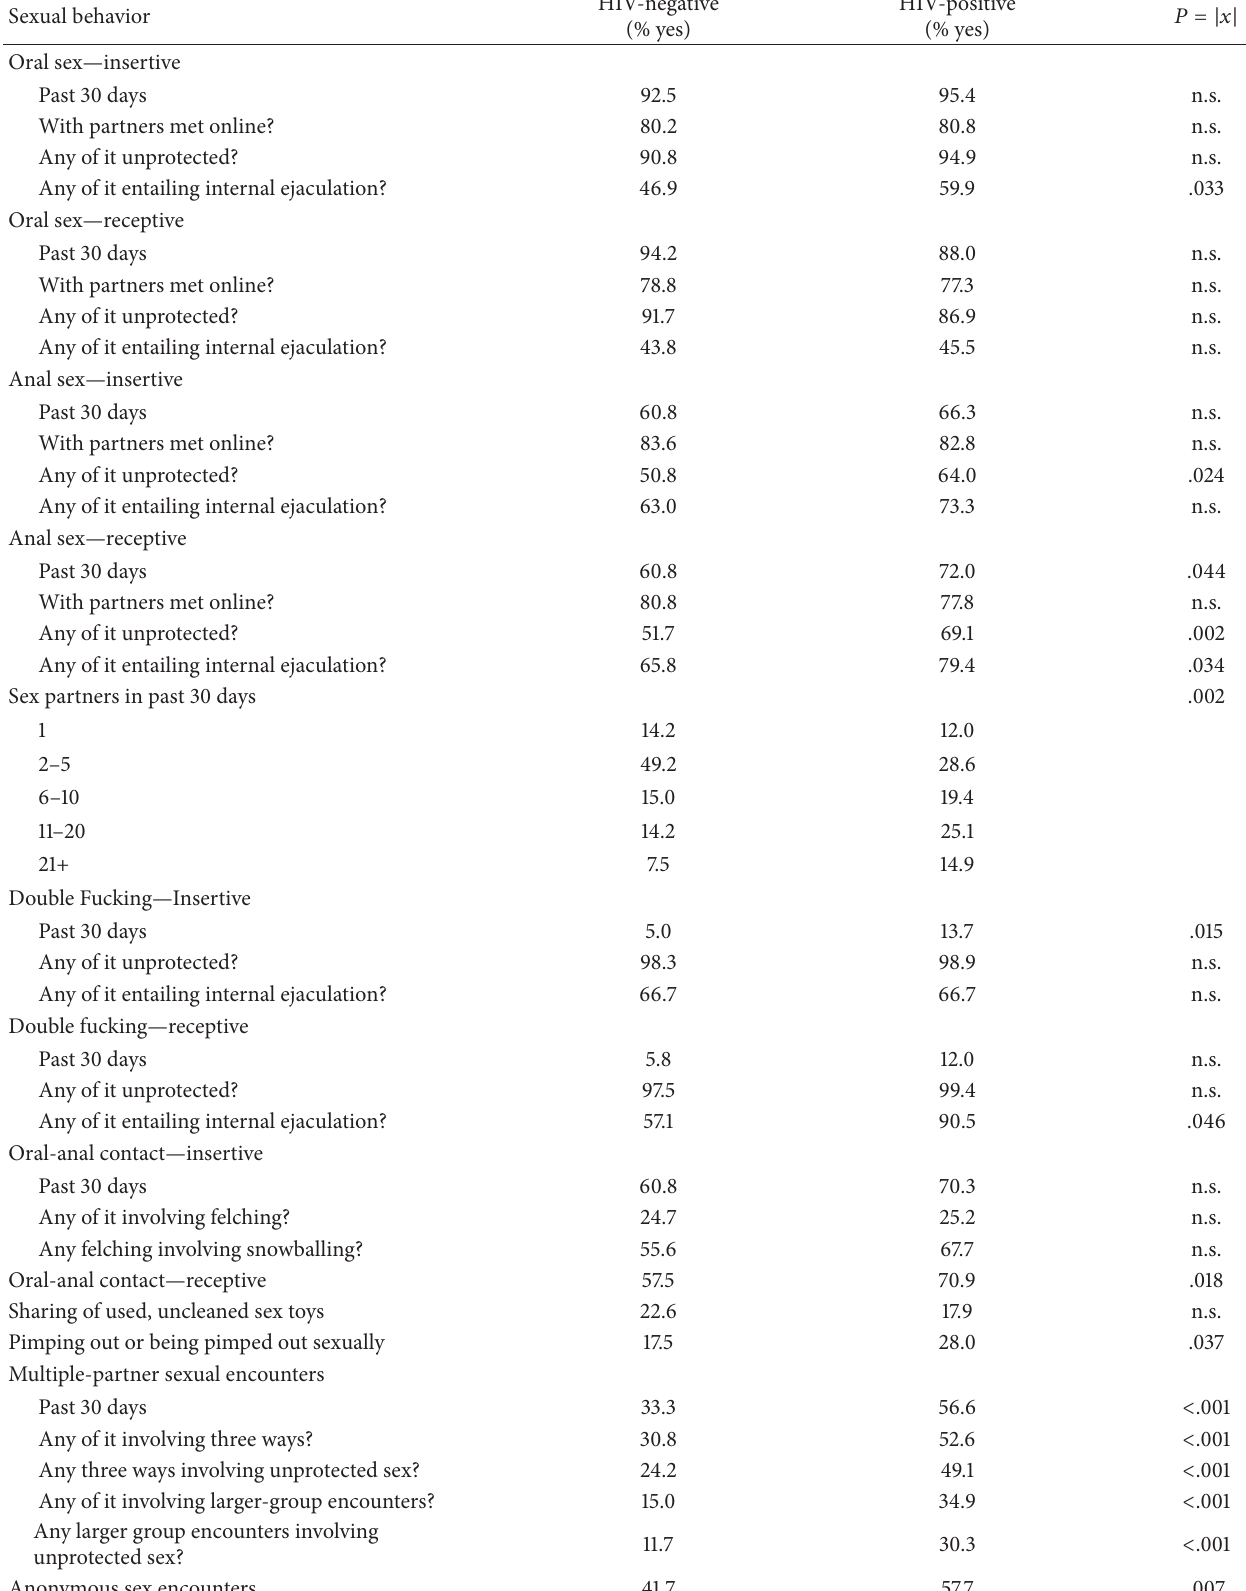
Table 3: Comparison of HIV-negative and HIV-positive men’s involvement in selected sexual behaviors among sexually active men. Sexual behavior